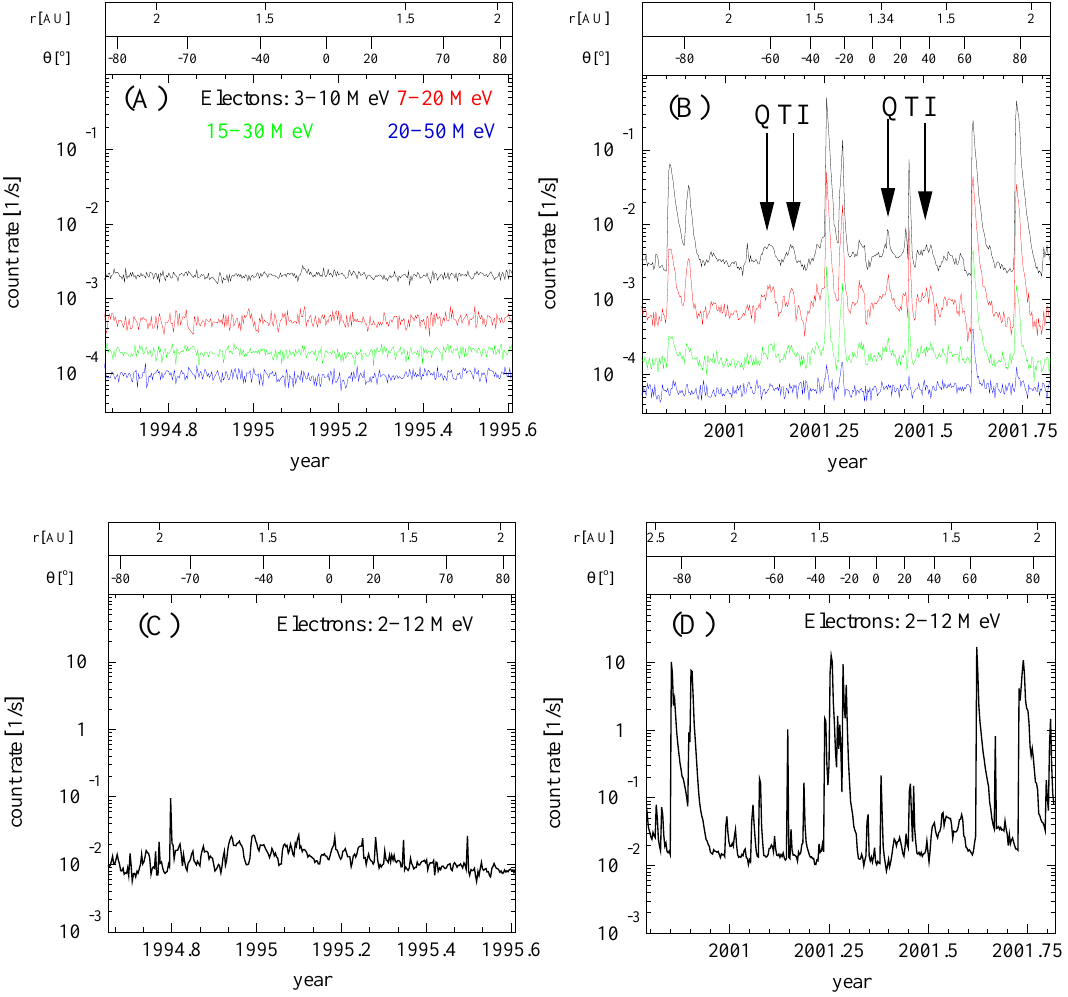
Fig. 7. Daily averaged count rates of different Ulysses/KET electron channels in the energy range from 3 to ∼ 50 MeV during the first (A) and second (B) fast latitude scan. The lower two panels (C) and (D) display the corresponding electron measurements in the energy range from 2 MeV to ∼ 12 MeV at Earth by the IMP 8